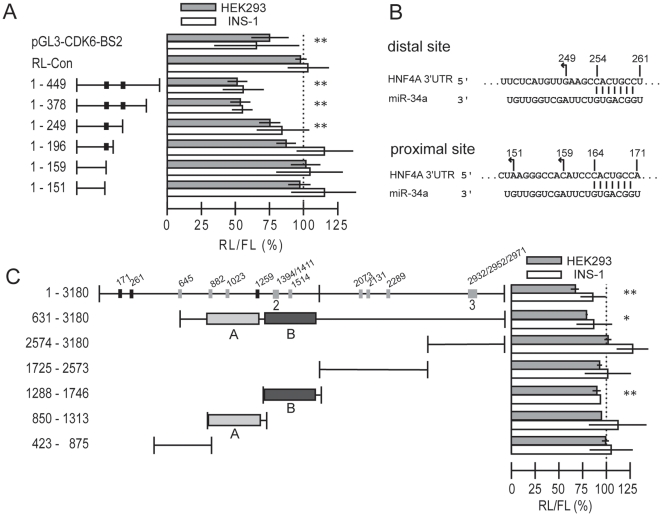
Reporter analyses of miR-34a binding sites in the HNF4A 3′UTR.(A) miR-34a targets two sites within the 5′ 449 nt of the HNF4A 3′UTR. Reporter plasmids and pri-miR-34a expression plasmids were co-transfected 24 h before cell collection, into HEK293 (upper grey bars) and INS-1 cells (lower white bars). At least one transfection assay was performed for each construct, involving two independent plasmid preparations in the case of two or more assays. Each assay was performed in triplicate and a CMV-driven firefly luciferase was used to control for transfection efficiency. The activity of each construct in the absence of the pri-miR-34a plasmid (replaced by Rc/CMV) was used for standardization (100%) and is not shown. pGL3-CDK6-BS2 [44] and pRL-Con [42] served as positive and negative controls, respectively. Since pGL3-CDK6-BS2 expresses the firefly luciferase, the RL-Con plasmid was used to control for transfection efficiency. The black boxes indicate miR-34a target sites with perfect seed sequence. To calculate p-values the data of HEK293 and INS-1 cells were combined for each construct. p-values are<0.05 (*) and <0.01 (**) using an independent-samples t test. (B) Schematic diagram of the two potential miR-34a binding sites within the 5′ 449 nt of the HNF4A 3′UTR. The numbering refers to the first nucleotide after the stop codon as 1. The site extending from 149–171 nt was only predicted by TargetScan and is little conserved, while the distal site located at 239–261 nt was predicted by RNA22 and TargetScan and is highly conserved among vertebrates. The two perfect seed matches are indicated by vertical lines between the HNF4A 3′UTR and miR-34a sequence. The arrows at position 151, 159 and 249 mark the last nucleotide of the HNF4A 3′UTR in the corresponding constructs. (C) Analyzing the performance of various 3′UTR fragments upon miR-34a overexpression as performed in panel A. The grey and black boxes indicate miR-34a target sites without and with a perfect seed sequence (CACUGCC), respectively, as determined by RNA22 [46]. The number of target sites indicated by a box is given underneath the target site in case of more than one site. The nucleotide positions of the 3′ end of the target sites are given. The negative elements A and B identified in Fig. S1 are indicated.